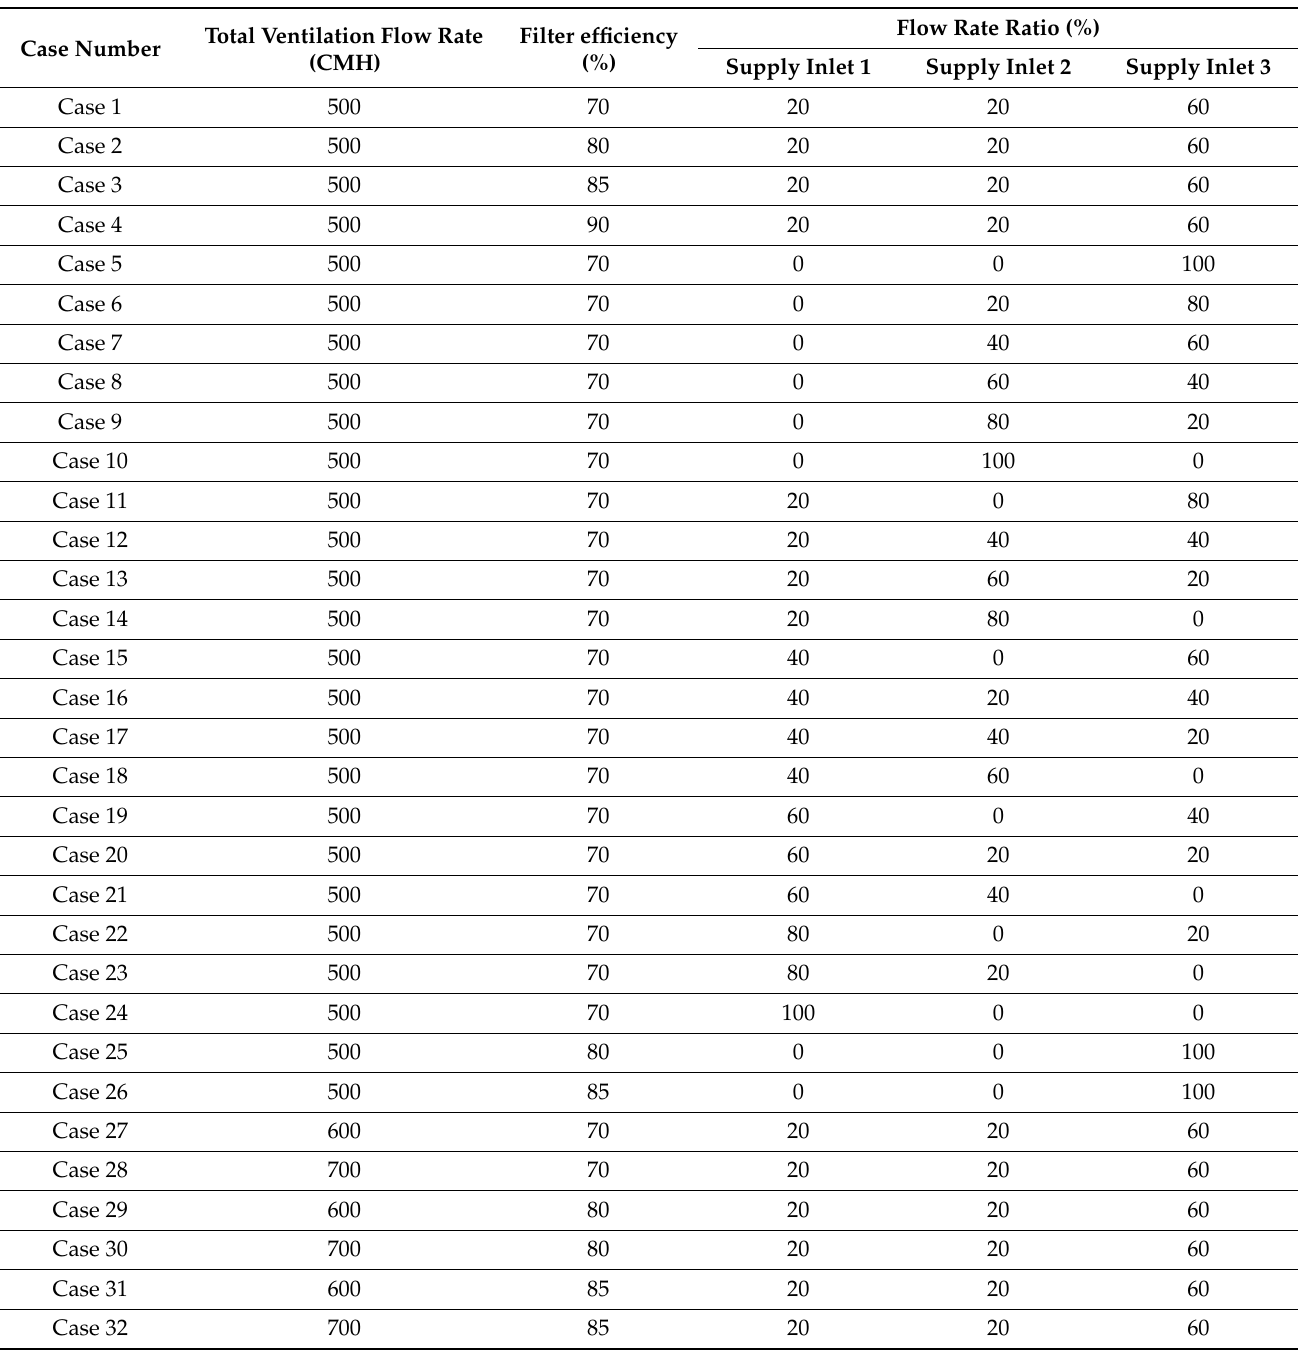
Table 2. All the cases considered in this study with varying the parameters of the total ventilation flow rate, filter efficiency, and flow rate